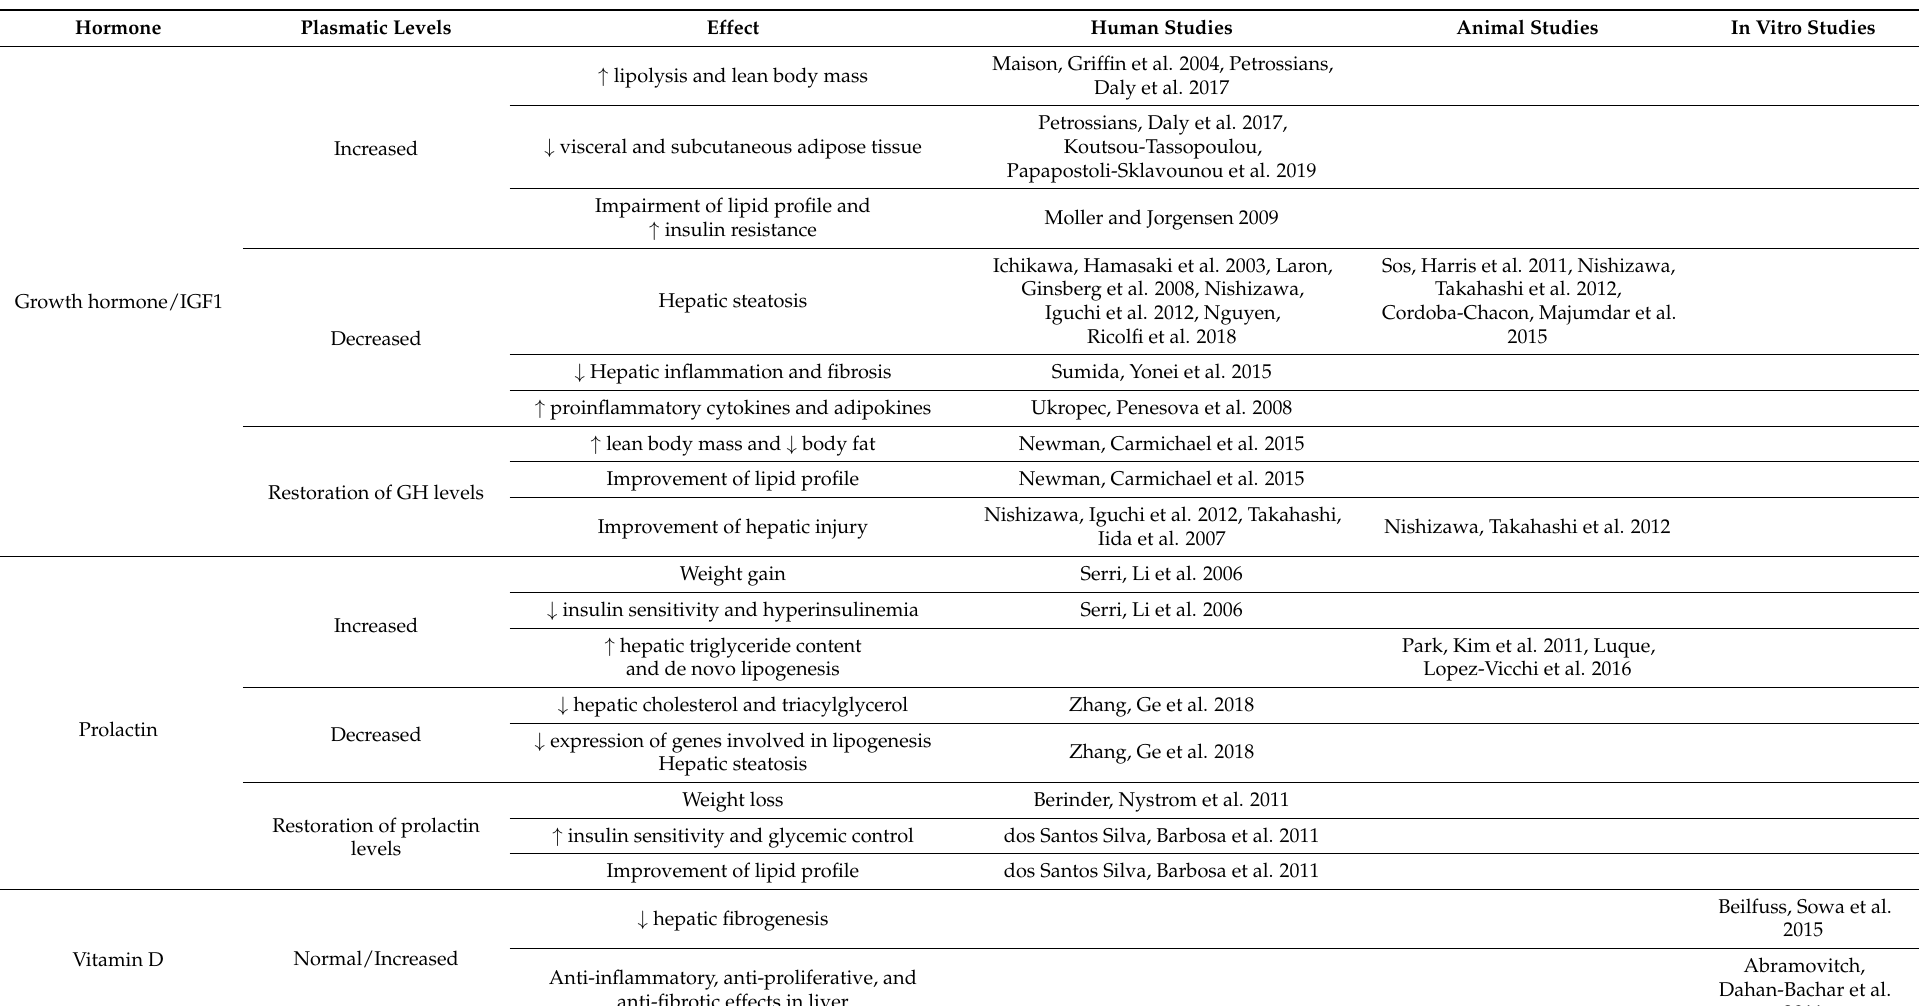
Table 1. Effect of endocrine hormones on the different factors involved in nonalcoholic fat liver disease